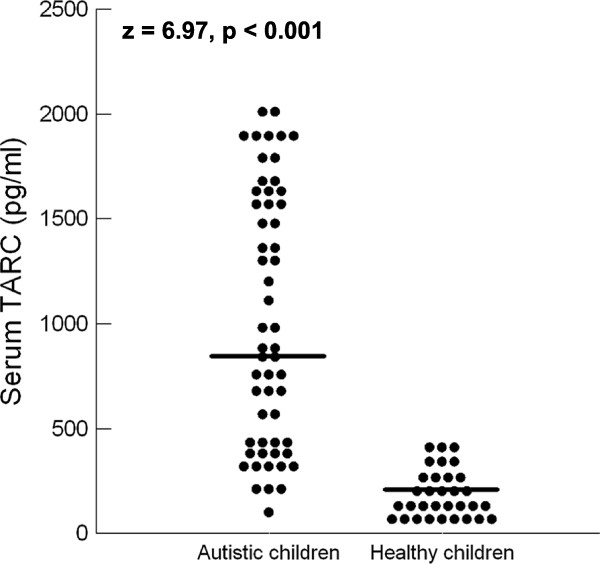
Serum levels of TARC in autistic patients and healthy controls. TARC, thymus and activation-regulated chemokine. Horizontal bars indicate the median values. TARC, thymus and activation-regulated chemokine.